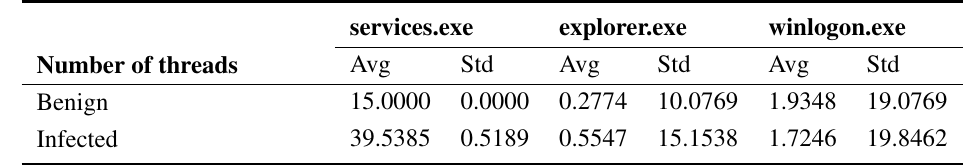
Table 4. Comparing the number of threads in benign and Flame-infected Windows system processes. Note that we indicate only the average and standard deviation statistics.